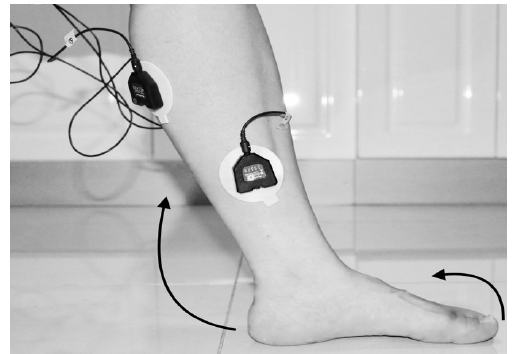
Figure 4. Collect data signals from the leg using sEMG